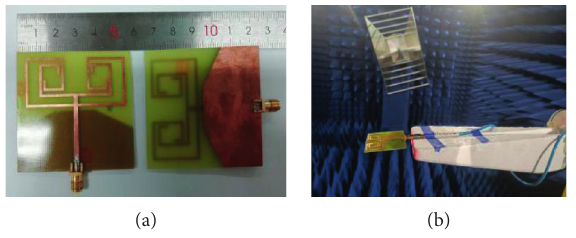
Figure 8: (a) Antenna physical object. (b) Antenna test.